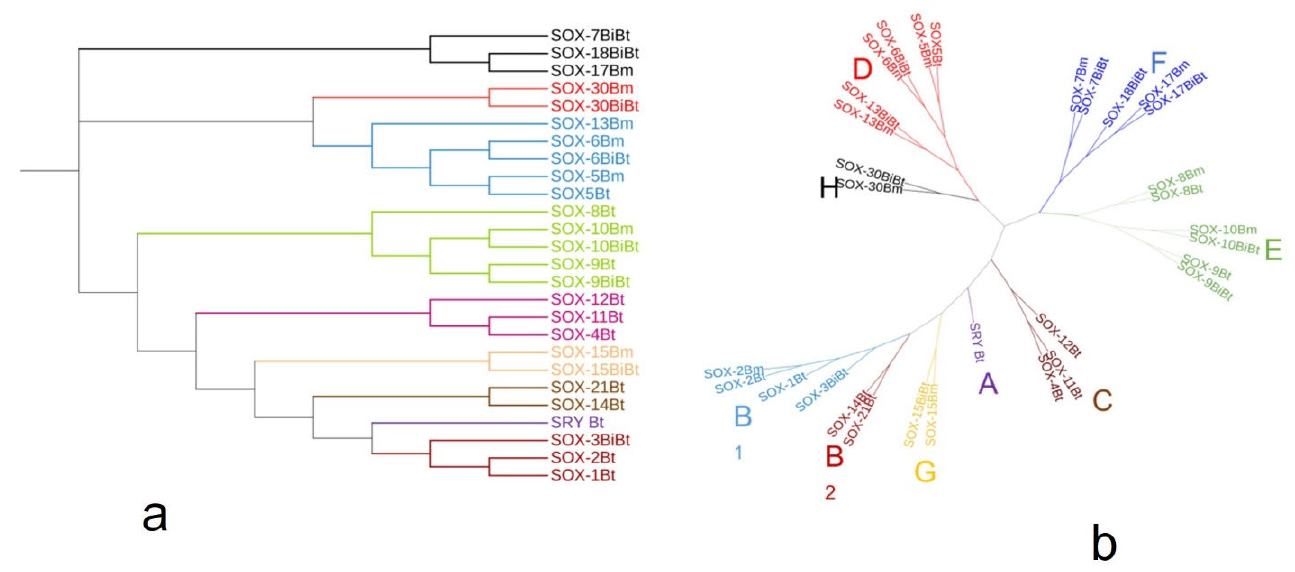
7 of 16 Figure 2. Multiple sequence alignment of Sox genes in Bos sp (SRY: Sex ‐ determining region Y, Bt: Bos taurus, BiBt: Bos indicus x Bos tautus, and Bm: Bos mutus. Colors were assigned by MEGA software based on the biochemical properties of the amino acids. Red, acidic; yellow, non ‐ polar neutral; cyan, positive polar basic; blue, positive polar; green, neutral polar; purple, neutral non ‐ polar; lime, neutral polar). Using the distance ‐ based method, we examined the phylogenetic relationships among the Bos Sox sequences. A phylogenetic tree based on the alignment showed that the Sox proteins are segregated into nine specific groups: A ( SRY ), B 1 ( Sox 1, 2, and 3), B 2 ( Sox 14 and 21), C ( Sox 4, 11, and 12), D ( Sox 5, 6, and 13), E ( Sox 8, 9, and 10), F ( Sox 7, 17, and 18), and Sox 15 and 30 are the sole members of Groups G and H, respectively (Figure 3a). The branch lengths, representative of the extent of divergence, suggest a monophyletic arrangement, with Sox B 1 diverging first. The result is further represented in an unrooted